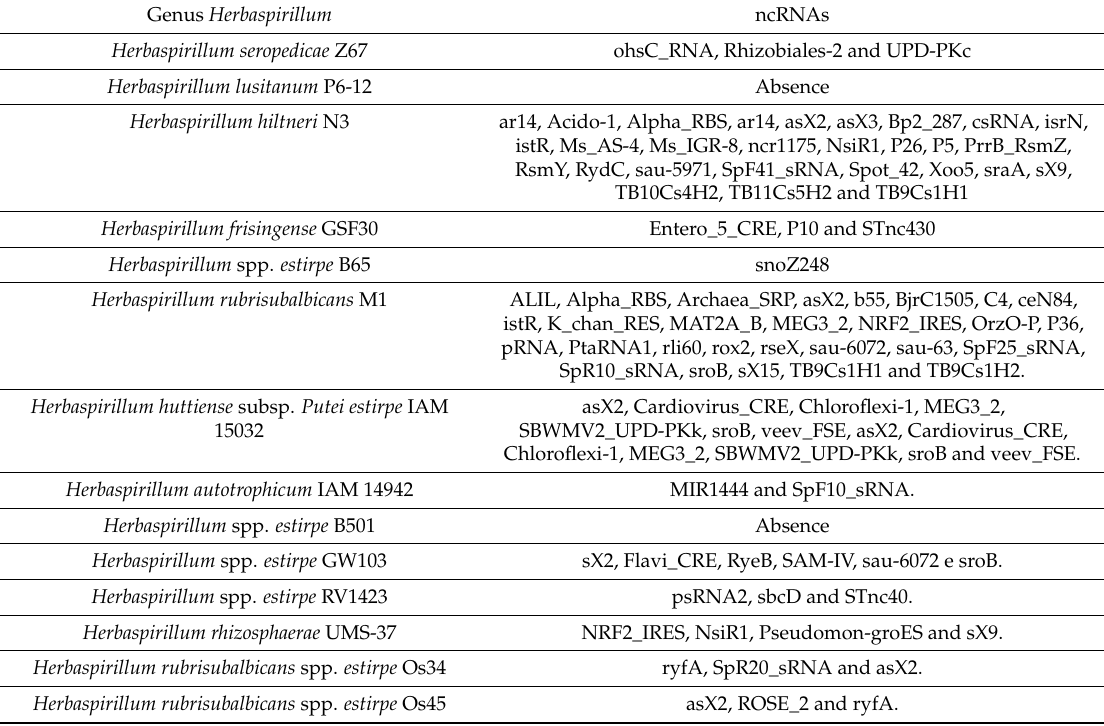
Table 1. ncRNAs predicted for bacteria of the genus Herbaspirillum and different from those already known in H. seropedicae SmR1. The Infernal (version 1.1.1) computational tool was